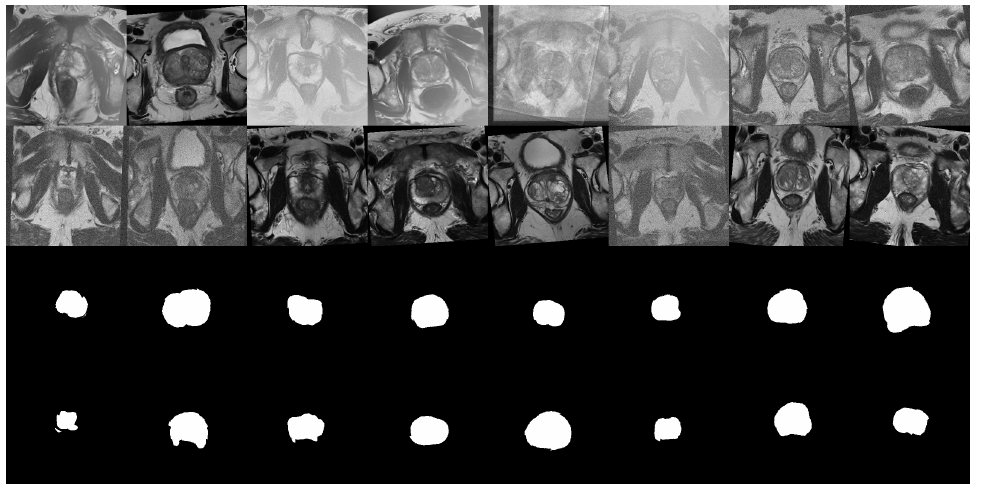
Figure 2. Example of a batch of 16 images, and their respective segmentation masks, from the ProstateX dataset after being pre-processed and augmented. Each image corresponds to the tenth slice of the volume. The images show the effect of the affine transformations as well as the random bias field